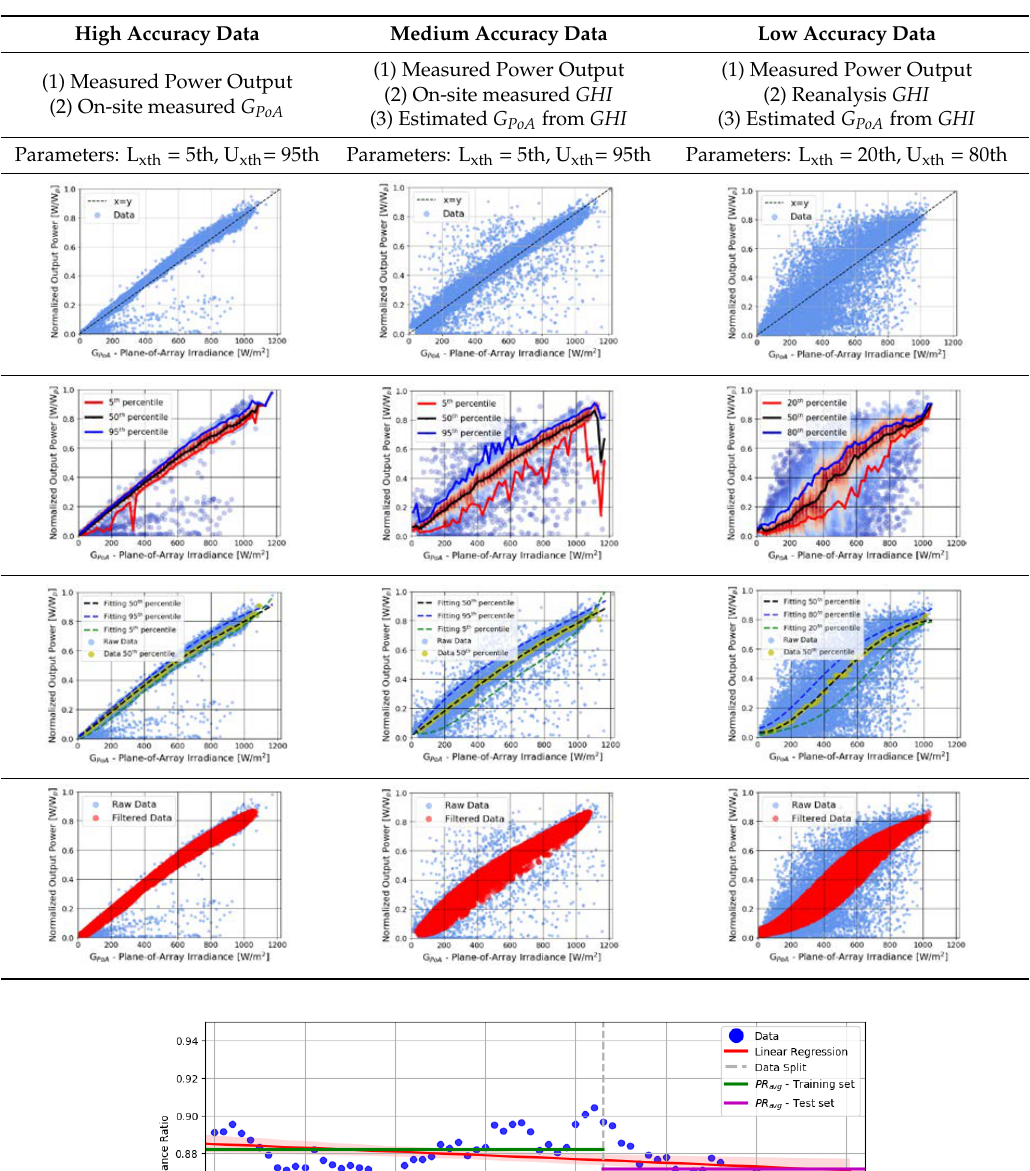
Table 2. Filtering algorithm step-by-step on the datasets for each level of data accuracy.